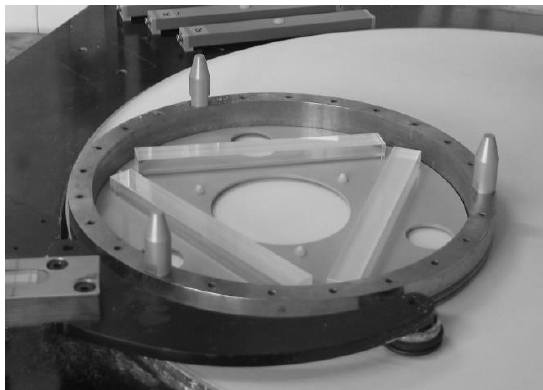
Figure 2. The sample mounting on the polishing tool used in commercially available polishing machines.